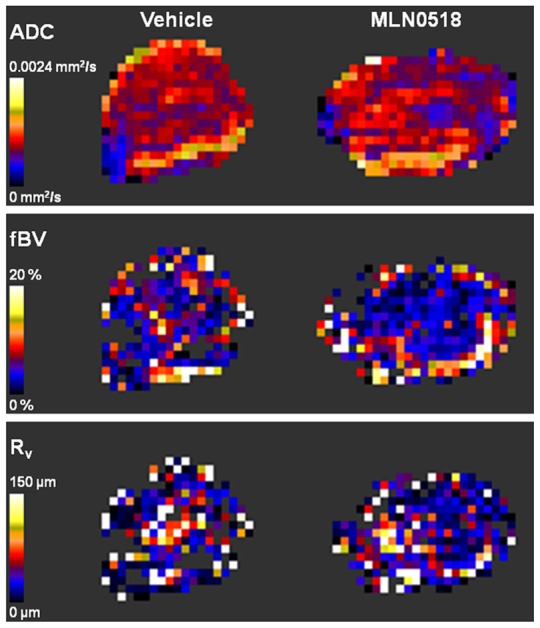
Diffusion-weighted and susceptibility contrast MRI of C6 tumours treated with MLN0518.Parametric maps of apparent diffusion coefficient (ADC, top panel), fractional blood volume (fBV, middle panel) and vessel size index (Rv, bottom panel) from C6 xenografts in mice treated with vehicle or 20 mg/kg MLN0518 for 10 days show no clear differences between vehicle and treated tumours. Representative maps are shown.